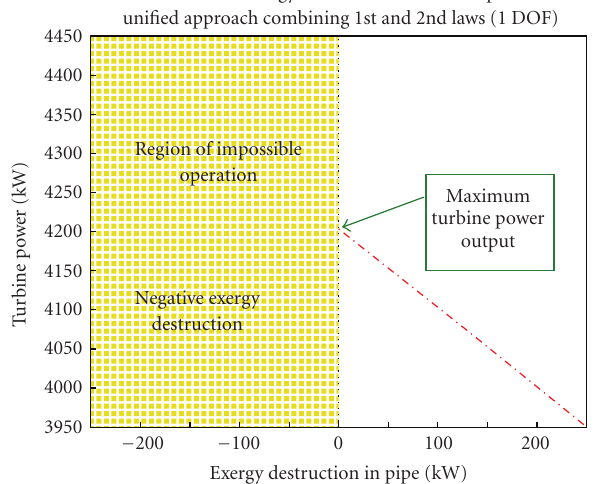
Figure 6: Graphical results of 1 DOF 1st and 2nd Law Analysis. Increasing exergy destruction results in reduced turbine perfor- mance. Note that only nonnegative exergy destruction is